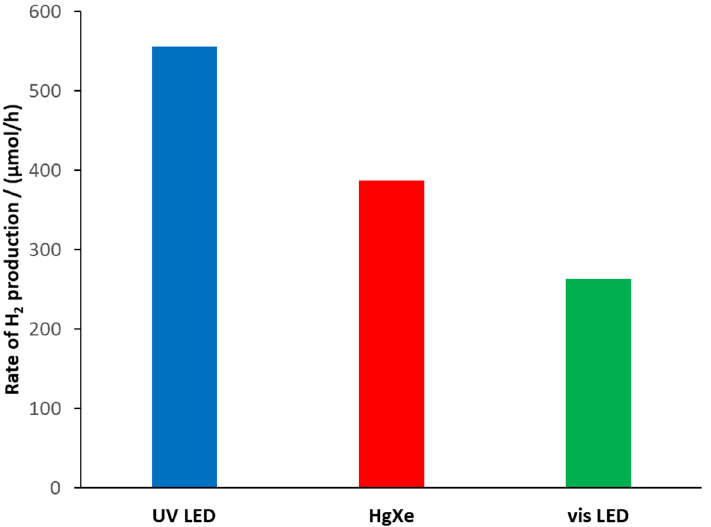
Figure 13. The overall rate of H 2 production for Cat-2N, using different light sources (vis LED, Xenon lamp, UV LED).